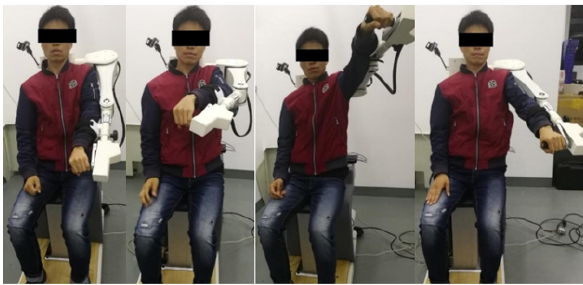
Figure 8. Active training control experiment.